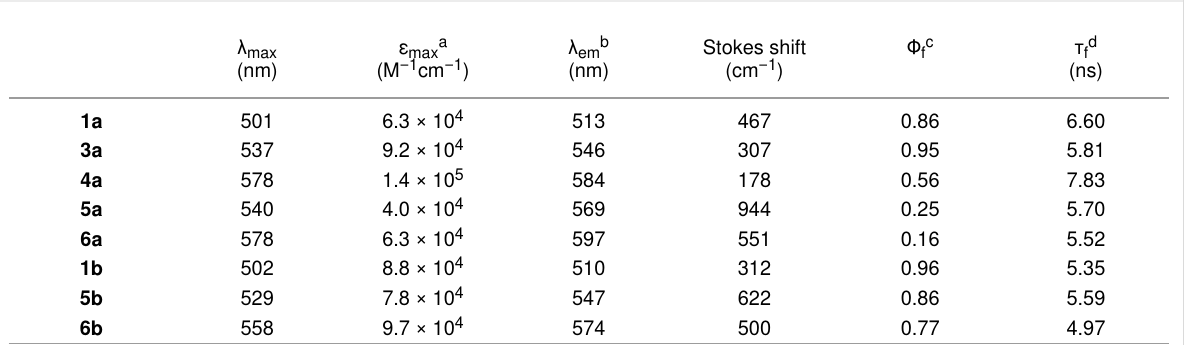
Table 1: Spectral properties of BODIPYs in CH 2 Cl 2 .